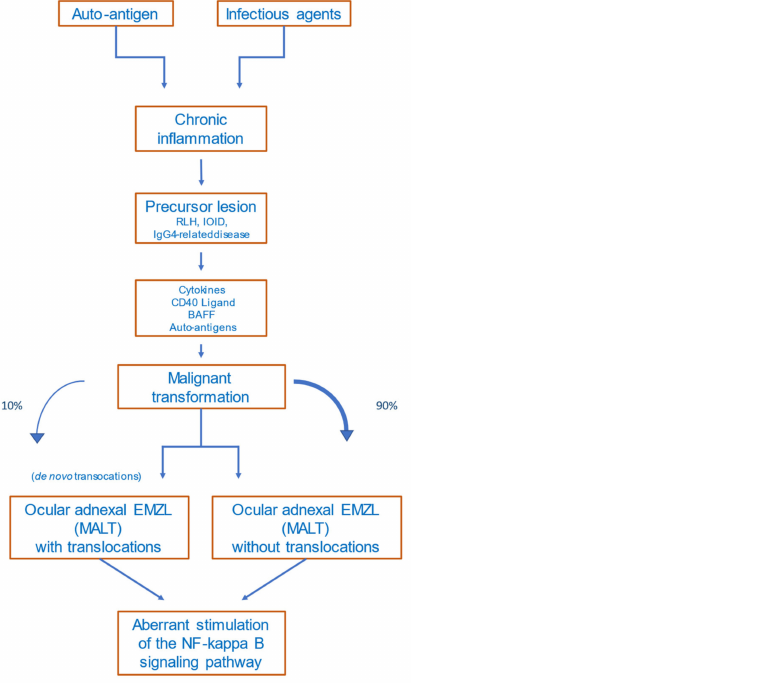
Figure 2. Proposed scheme of OAMZL pathogenesis. RLH: reactive lymphoid hyperplasia; IOID: idiopathic orbital inflammatory disease; BAFF: B-cell activating factor; EMZL: extranodal marginal- zone lymphoma; MALT: mucosa-associated lymphatic